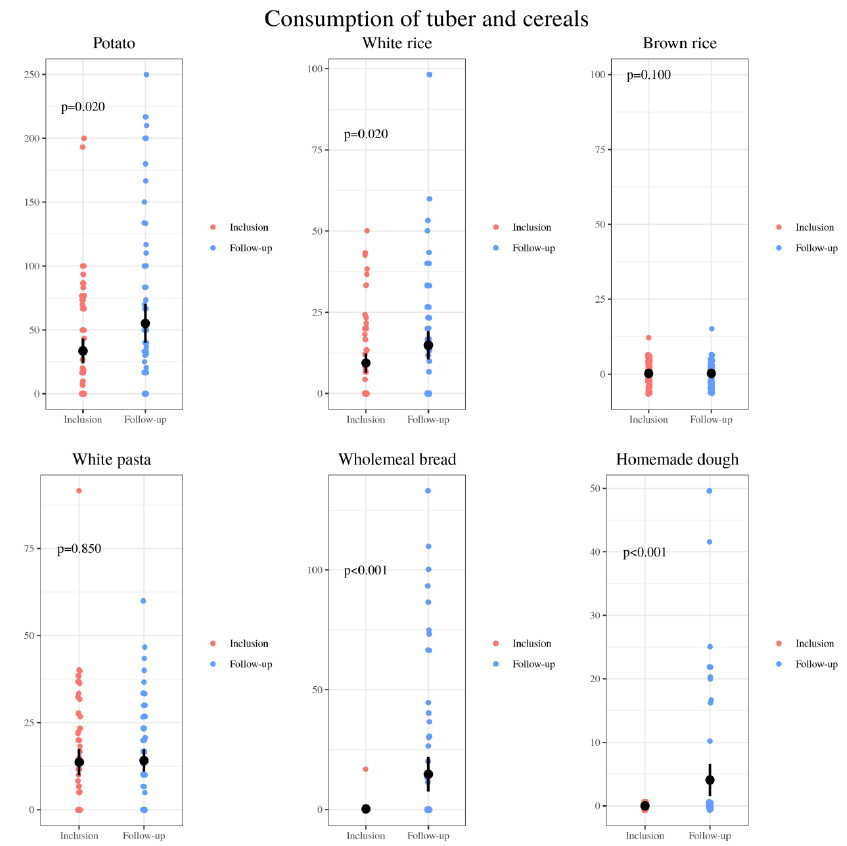
Figure 7. Comparison of the relative consumption of tubers and cereals: grams of potato, white rice, brown rice, white pasta, wheat bread and homemade dough per day consumed by 72 CD pediatric individuals at baseline (inclusion) and after nutrition intervention (follow-up).